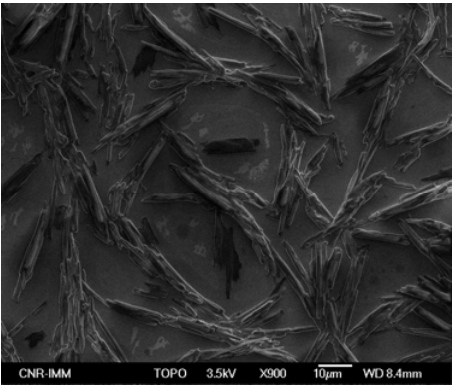
film on <100> Si substrate 2